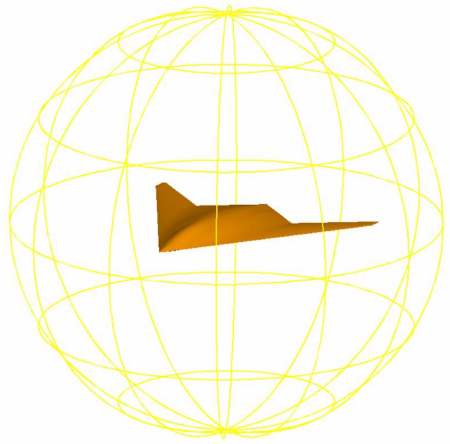
Figure 1. Calculation of the probability of detection in the 4 π